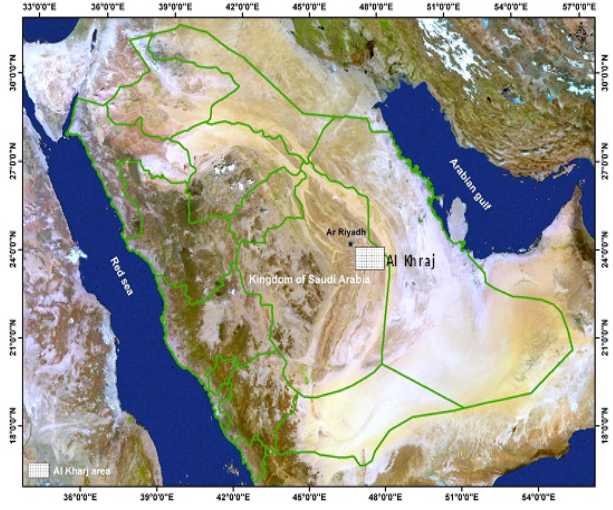
Figure 1. Location of the study